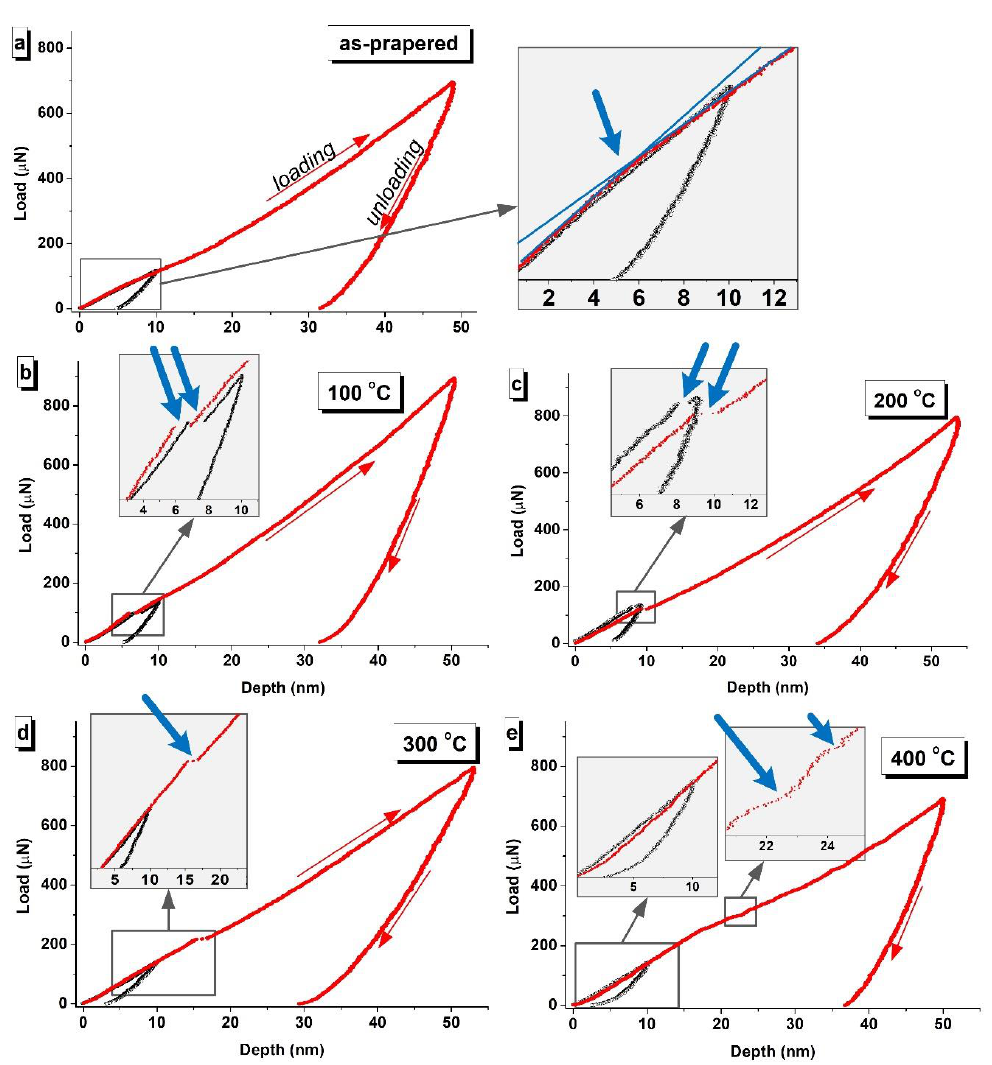
Figure 4. Characteristic deformation curves (loading-unloading) obtained by nanoindentation at the depth of 10 nm (black dots) and 50 nm (red dots) of the ( a ) as-prepared Au/NiFe nanostructured system and the same system after heat treatment with ( b ) 100 °C, ( c ) 200 °C, ( d ) 300 °C, and ( e ) 400 °C. The blue arrows indicate the moment the indenter passes through the interface of oxide and metal.